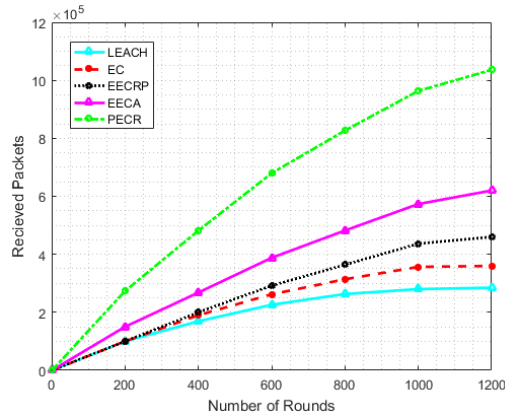
Figure 7. Packets received by the BS.